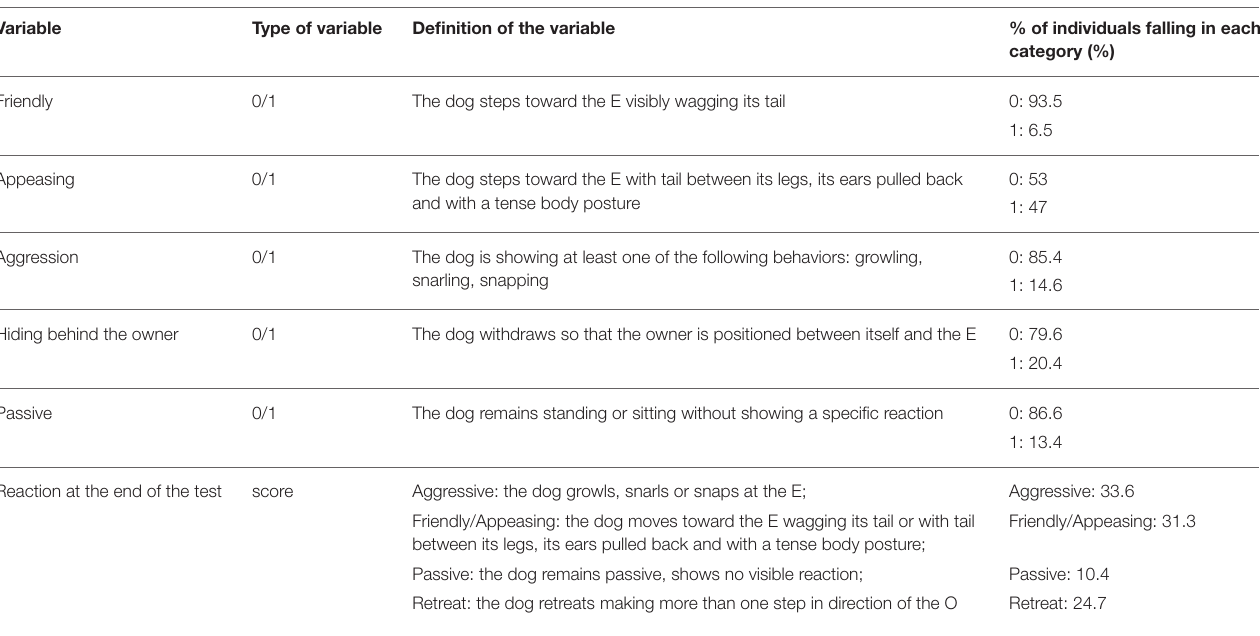
TABLE 2 | Behavior variables scored during the threatening approach